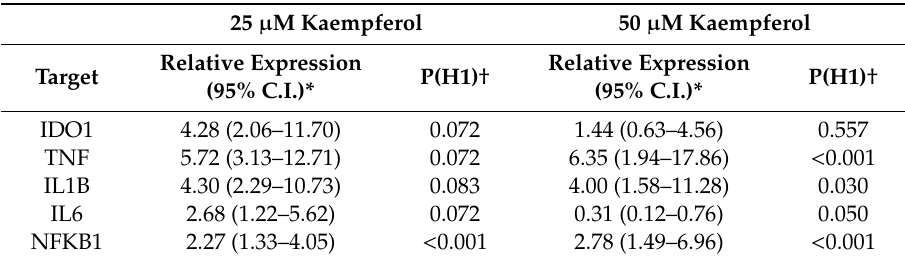
Table 1. Relative quantification of IDO1 and NF- κ B1 target gene mRNA expression in THP1-Blue cells treated with di ff erent concentrations of kaempferol for 24 h, in comparison to LPS plus vehicle treated control cells (expression set as